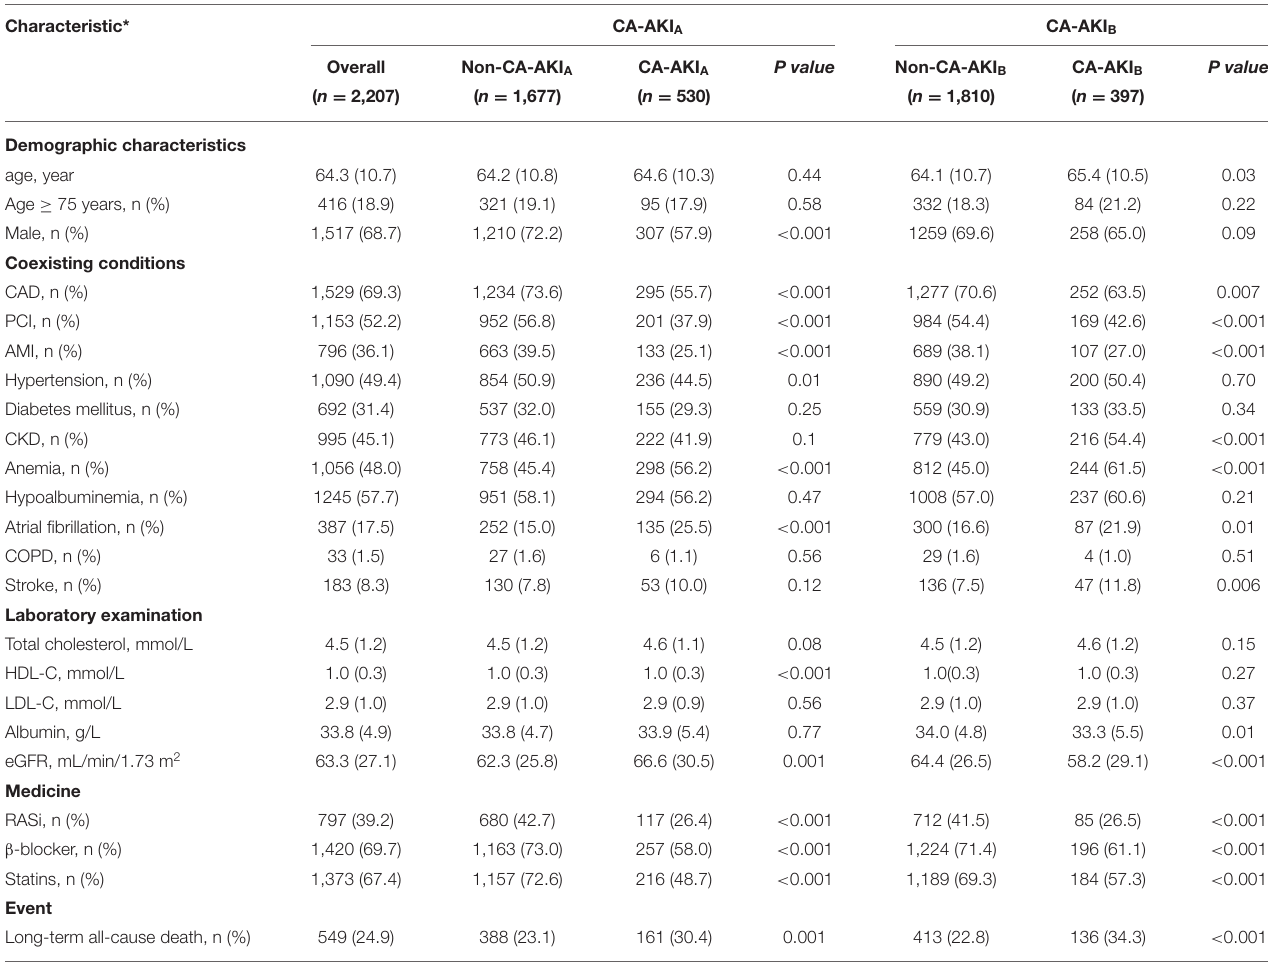
TABLE 1 | Baseline